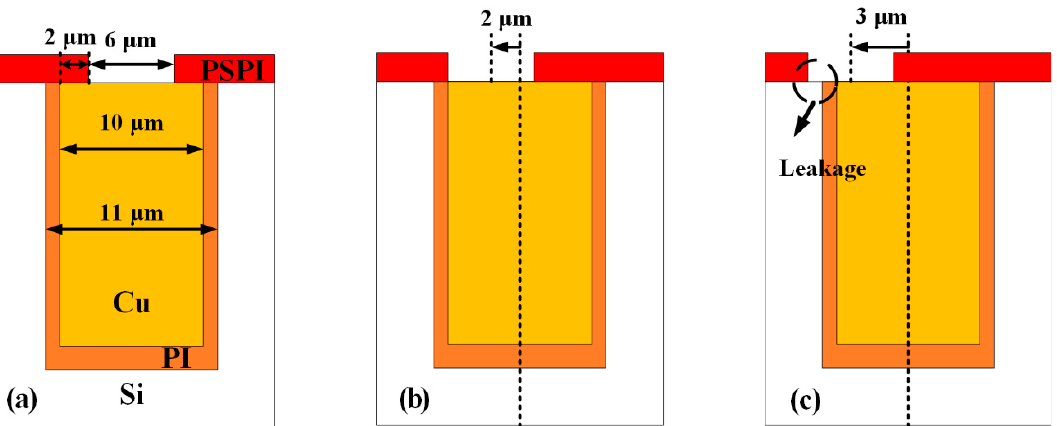
Figure 4. Schematic of lithography alignment of PSPI insulating layer: ( a ) ideal situation, ( b ) slight deviation, ( c ) serious deviation.